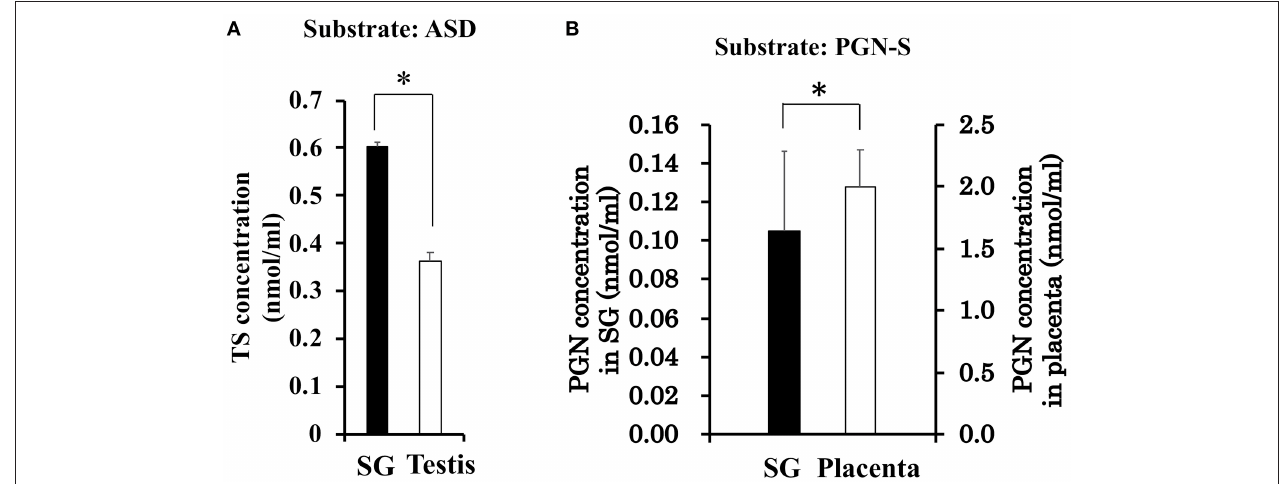
FIGURE 4 | (A) Enzymatic activity associated with testosterone (TS) synthesis in rat salivary gland (SG) and rat testis. The concentration of TS produced from androstenedione (ASD) was determined by LC-MS analysis after a 2-h enzymatic reaction using homogenates of rat SG ( n = 3, closed bars) and rat testis ( n = 3, open bars). (B) Enzymatic activity associated with sulfate de-conjugation in rat salivary gland (SG) and rat placenta. The concentration of pregnenolone (PGN) produced from pregnenolone sulfate (PGN-S) in rat SG ( n = 3, open bars) and rat placenta ( n = 3, closed bars). Data are shown as the mean ± S.D. * p <